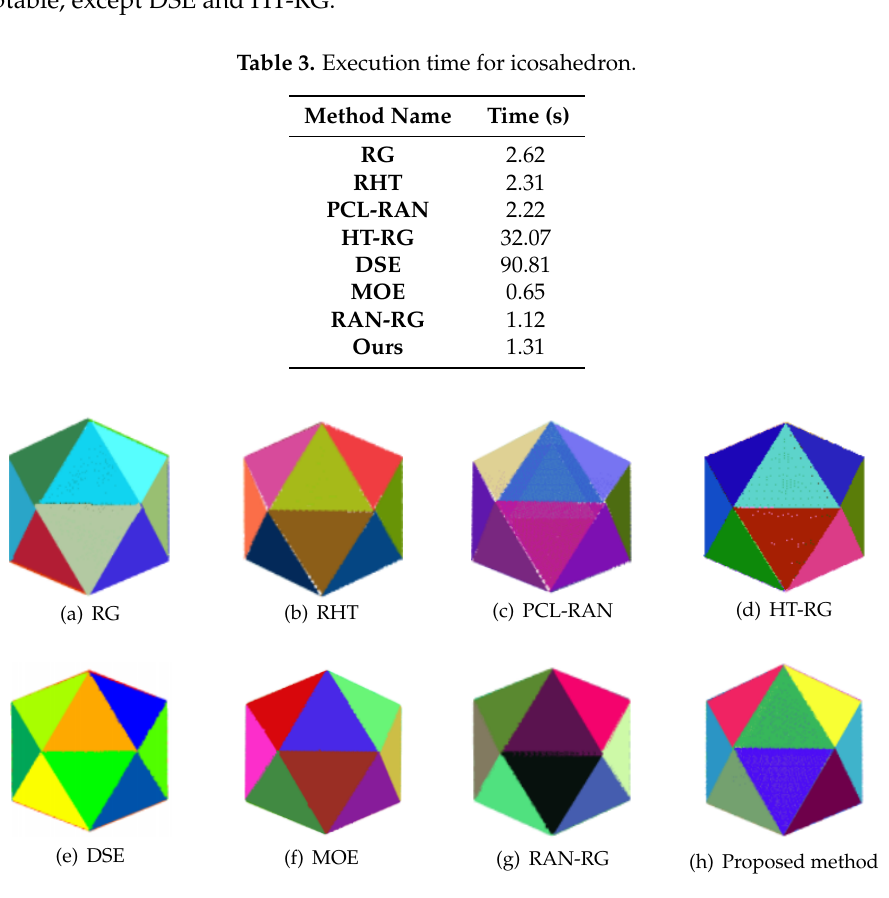
Figure 8. Detection results for the